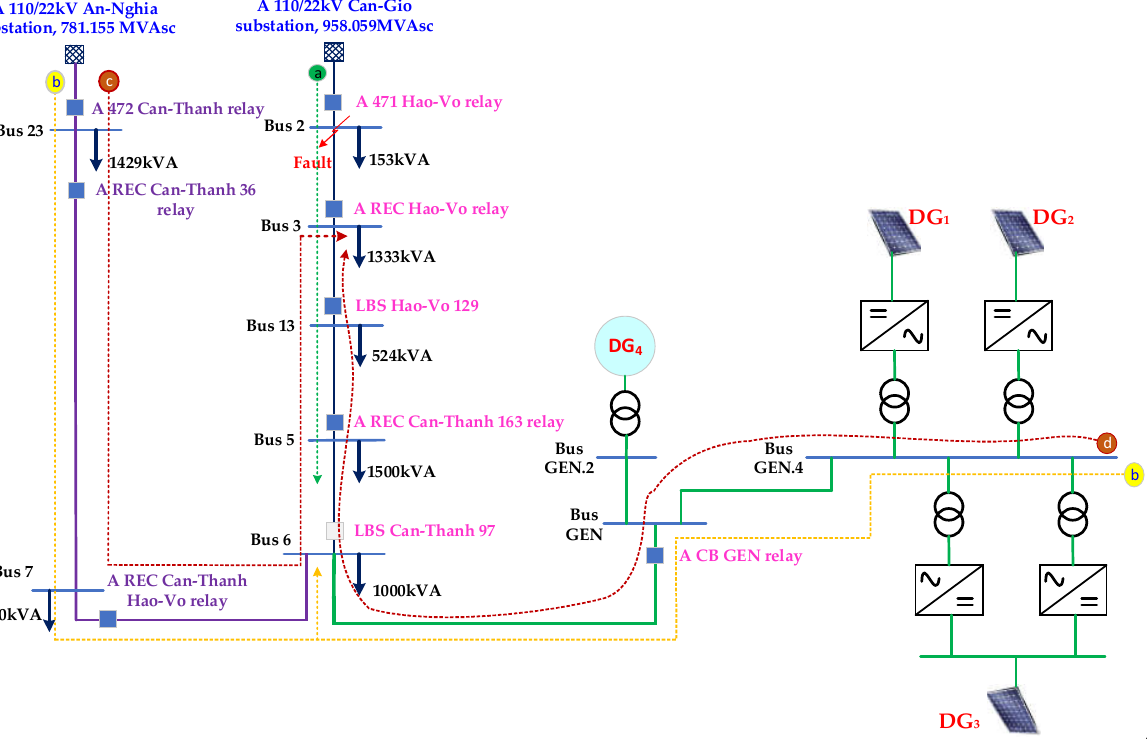
Figure 10. A simplified single-line diagram of the real 22 kV DG-integrated DN.